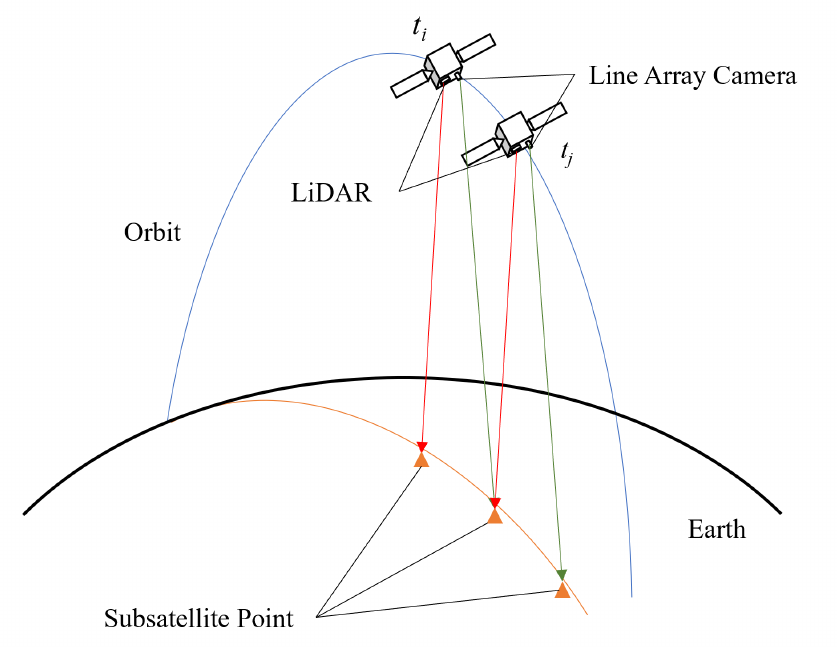
Figure 6. Earth observation by line array camera and